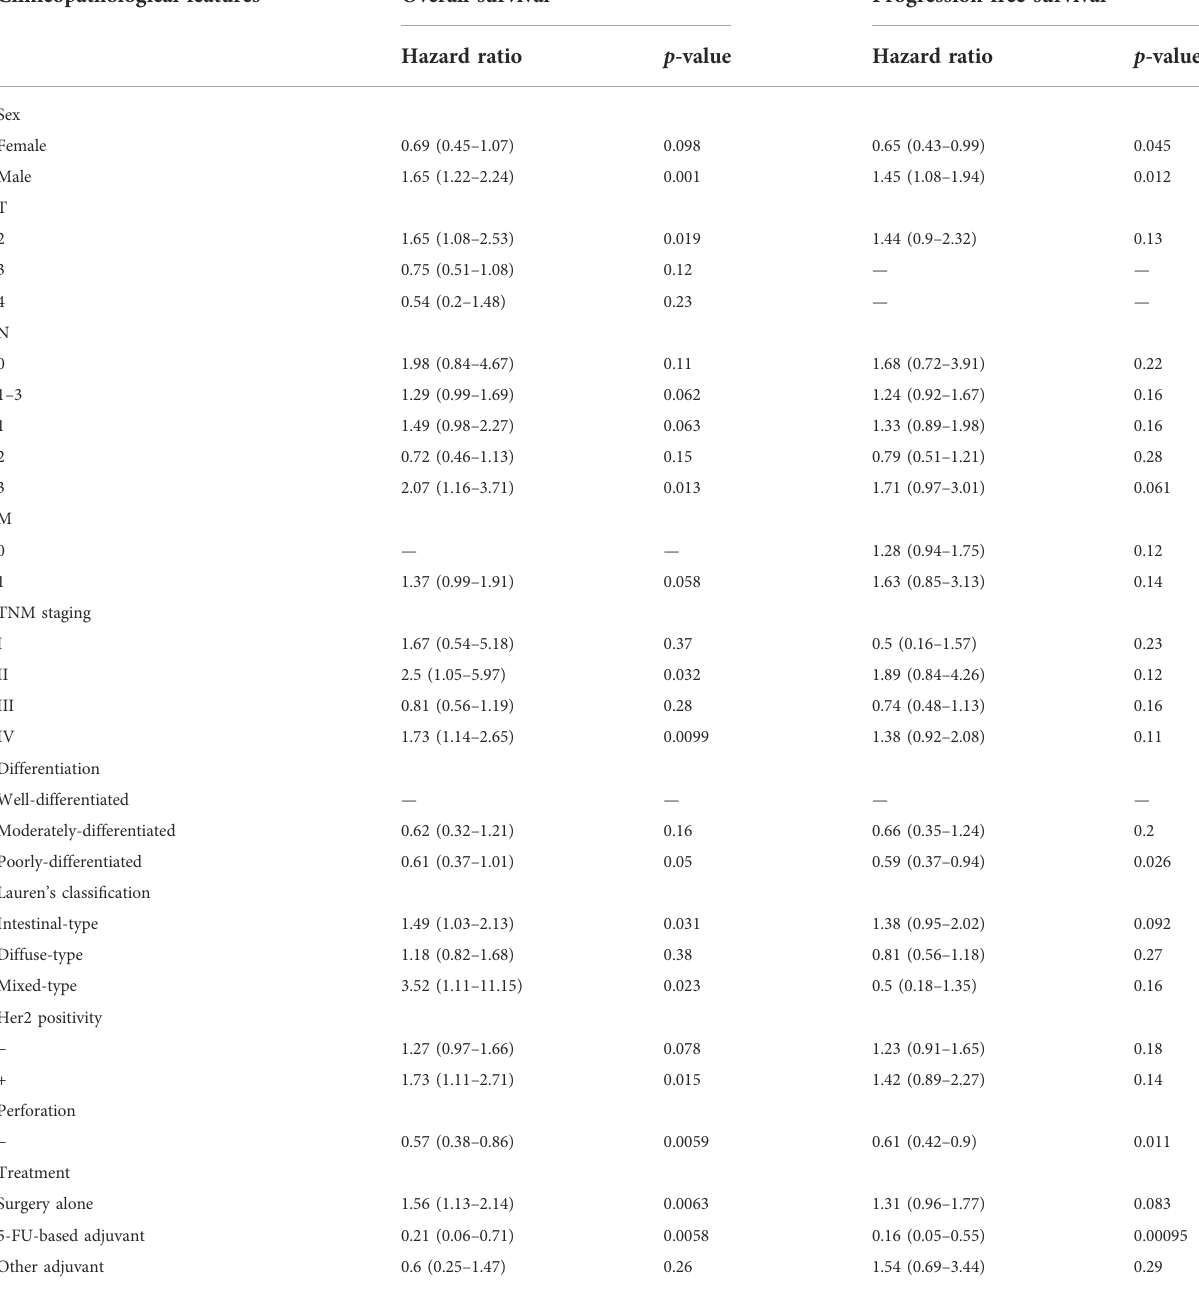
TABLE 1 The prognostic signi fi cance of BTG1 mRNA in gastric